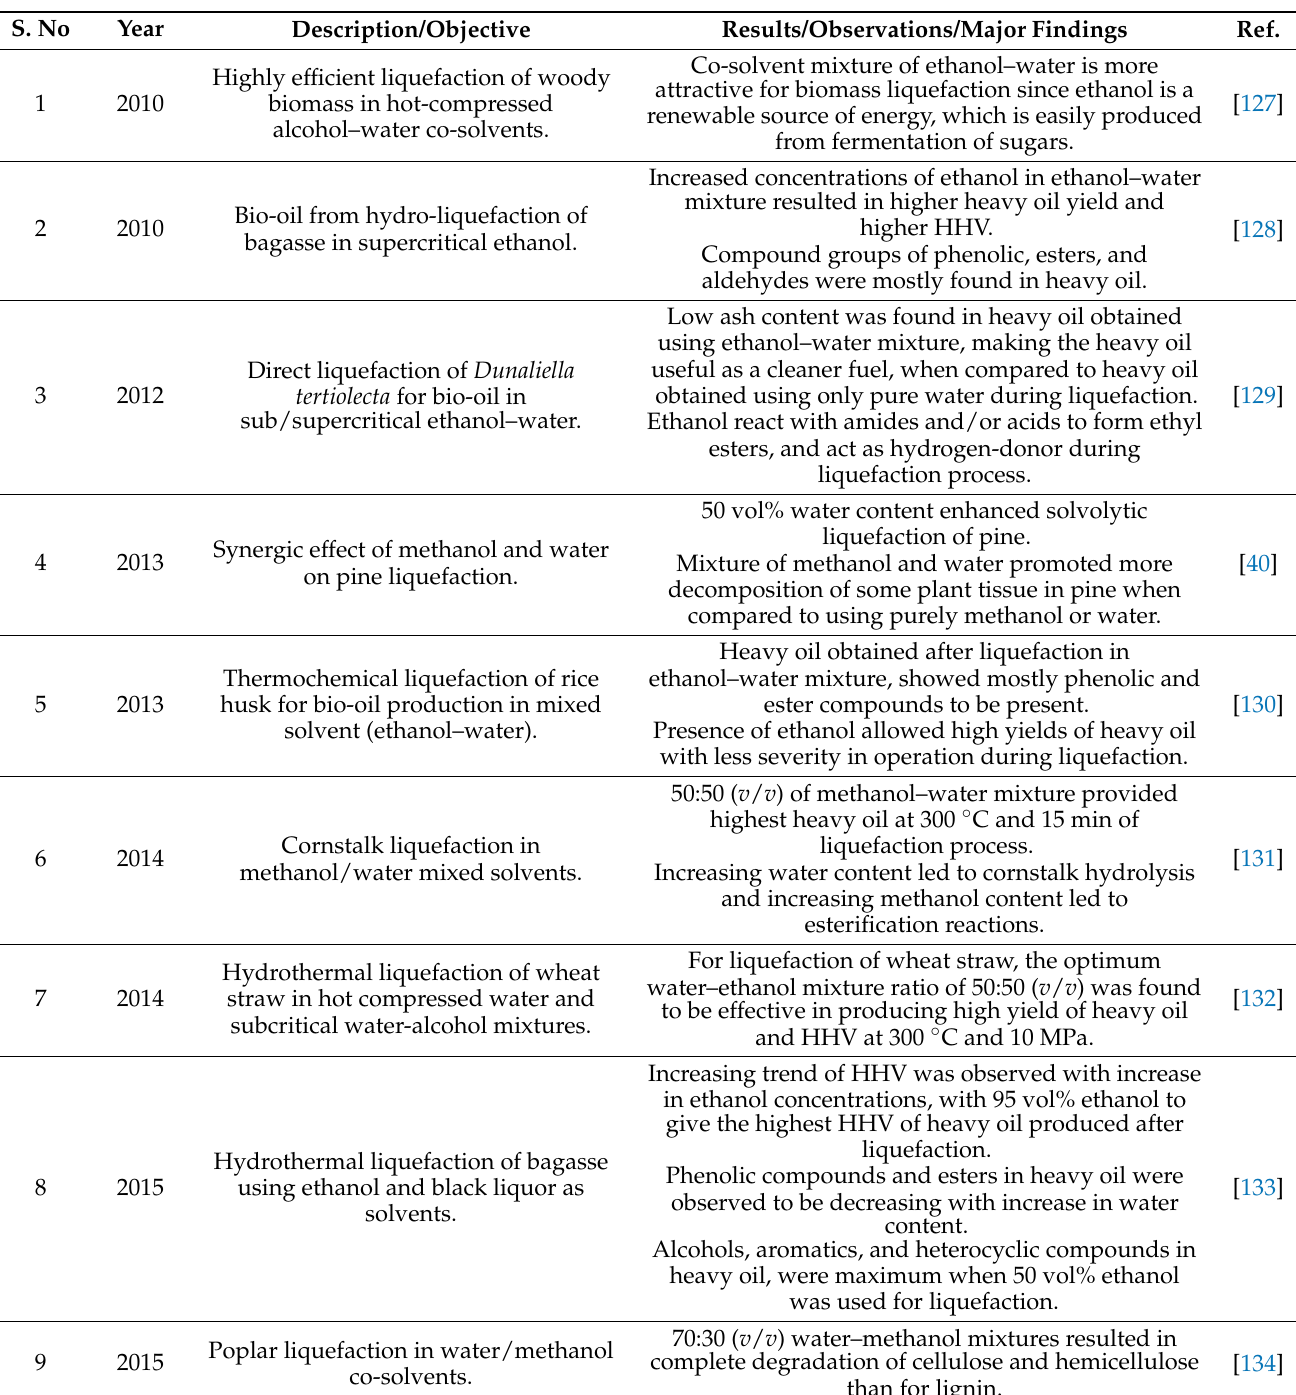
Table 10. Studies focused on effect of various solvents for